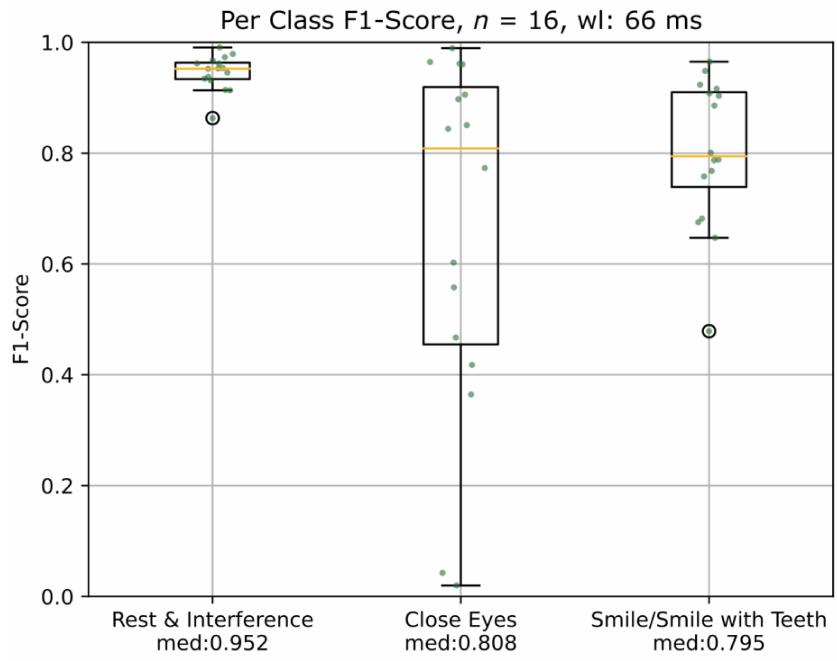
Figure 4. Boxplots of the comparison of the results of the F1-scores for the different tasks using the two best-performing muscles in each patient. wl = window length; med = median macro F1-score.